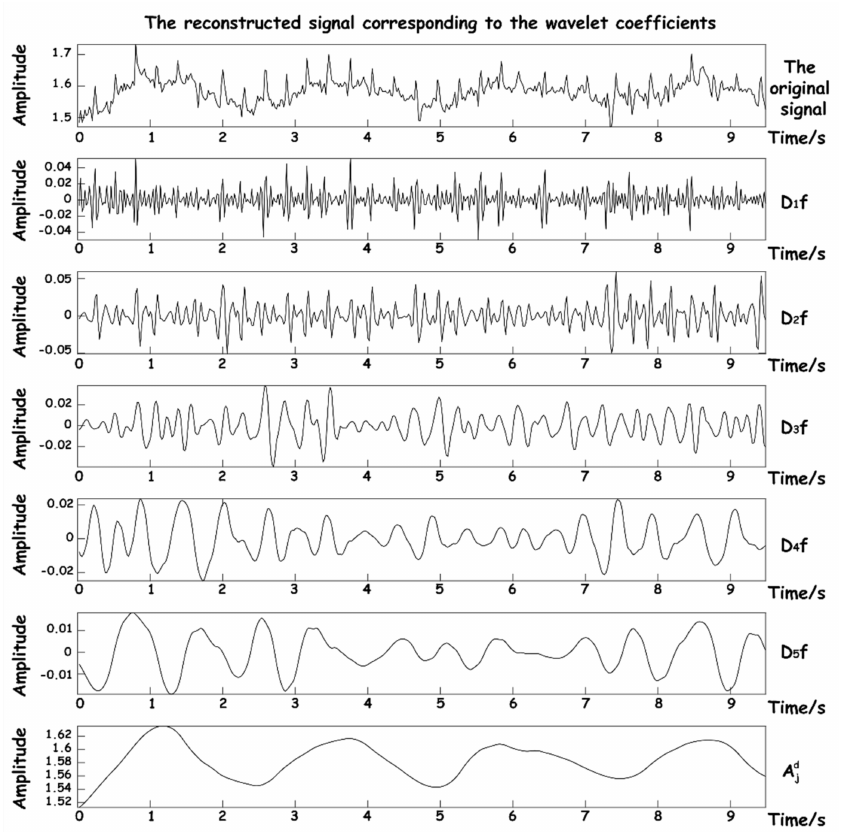
Figure 8. Reconstructed signal graphs at various scales.